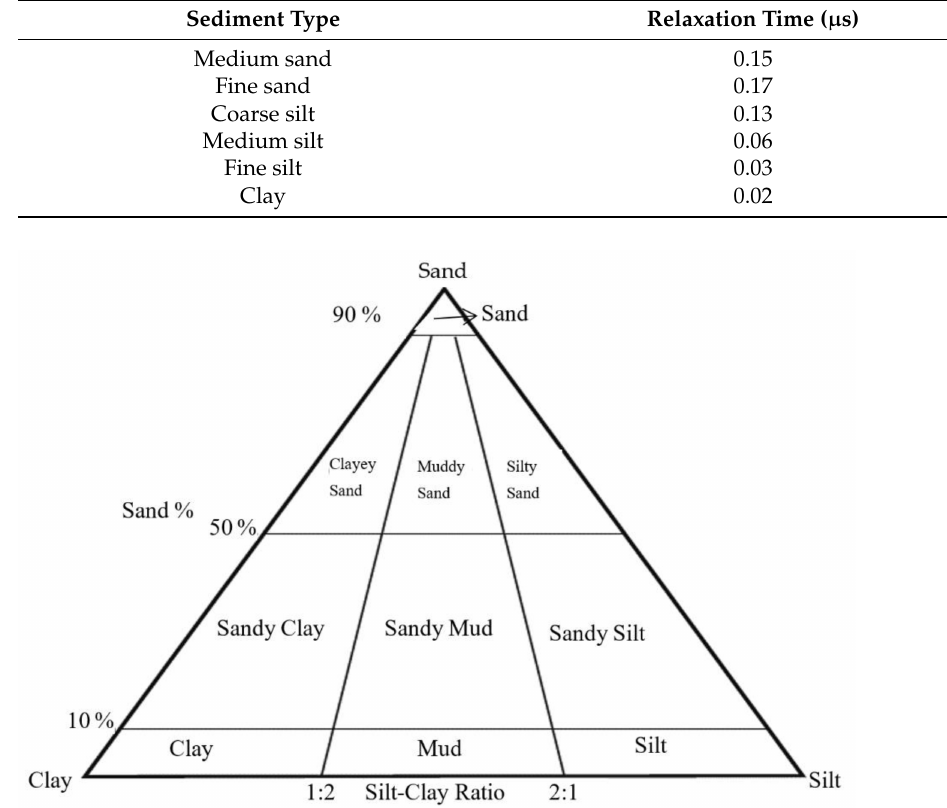
Table 2. Average relaxation time for different sediment types.